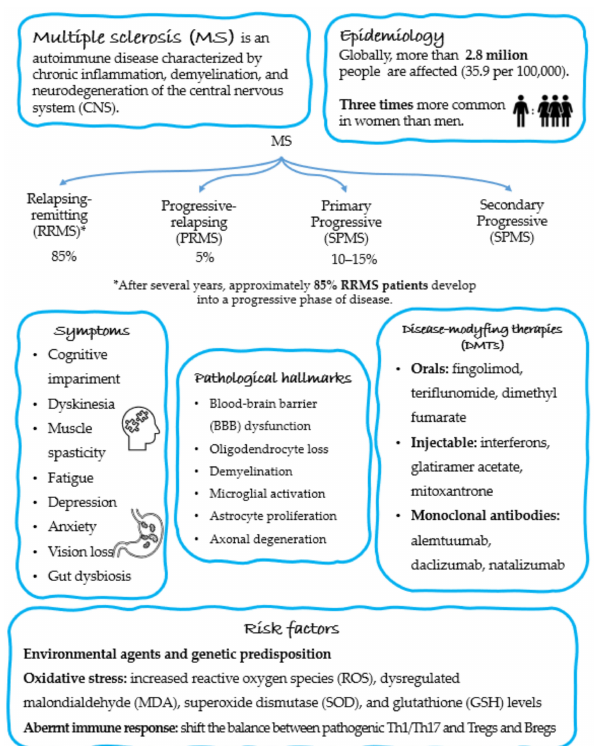
Figure 2. Characteristic and epidemiology of MS. It presents the division of MS into subtypes with their percentage occurrence, a list of the most common symptoms, current use of DMTs, identified pathological hallmarks, and general risk